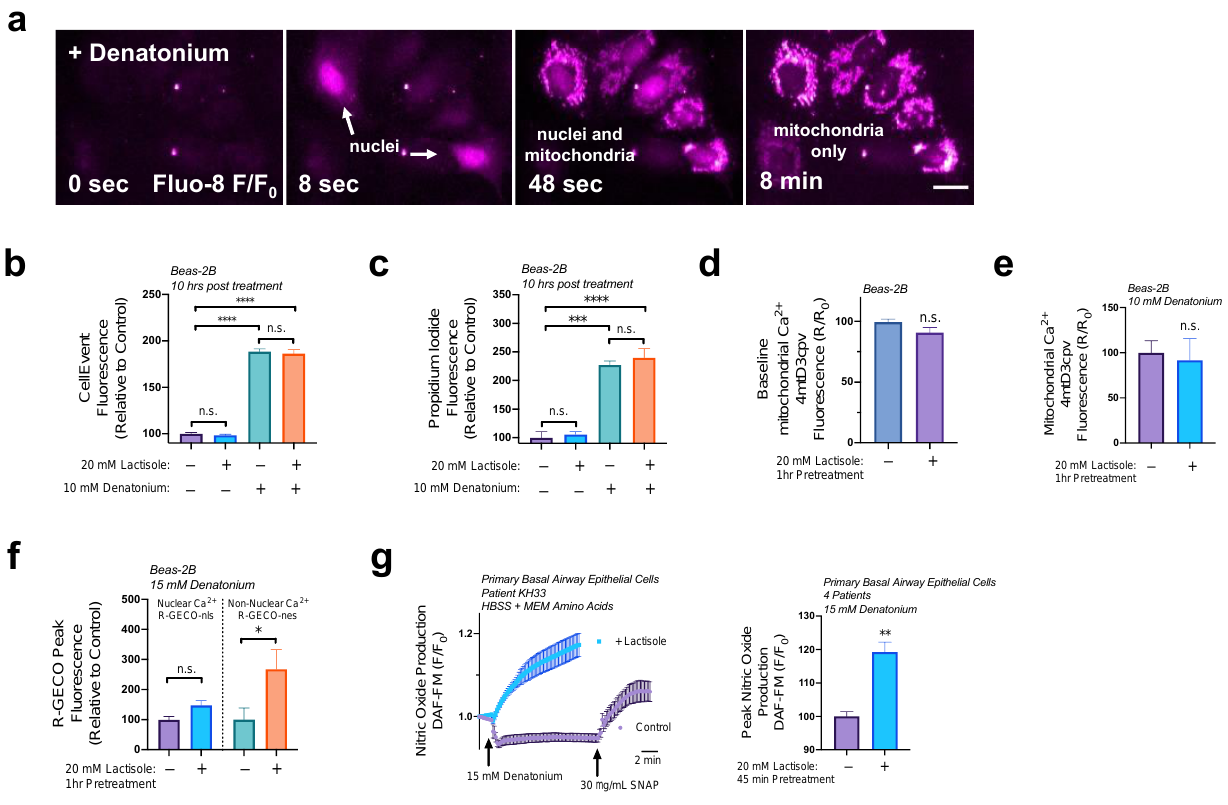
Figure 6. Lactisole increases denatonium-induced cytosolic Ca 2+ elevations and NO production. ( a ) Fluorescence images showing time course of denatonium-induced Ca 2+ elevations in starting nuclei then persisting in the mitochondria in airway epithelial cells; original image summarizing our findings from [24]. ( b ) The 20 mM lactisole pretreatment (1 h) does not alter caspase 3/7 activity initiated by denatonium signaling pathways. ( c ) The 20 mM lactisole pretreatment (1 h) does not alter cell death initiated by denatonium signaling pathways as detected by propidium iodide staining. ( d ) No changes in baseline mitochondrial Ca 2+ levels with 20 mM lactisole pretreatment (1 h) were observed in Beas-2B cells. ( e ) There were no significant changes in denatonium-induced mitochondrial Ca 2+ elevations with 20 mM lactisole pretreatment (1 h) in Beas-2B cells. ( f ) The 20 mM lactisole pretreatment (1 h) increased denatonium-induced non-nuclear Ca 2+ elevations and had no effect nuclear Ca 2+ elevations. ( g ) Primary basal airway epithelial cells in the presence of 1x MEM AA and with 20 mM lactisole pretreatment (1 h) initiate NO production in response to 15 mM denatonium. Traces are representative of ≥ 3 experiments. Bar graphs containing two comparisons were analyzed via t -test; bar graphs containing >2 comparisons were analyzed via ANOVA using Bonferroni’s post-test for multiple comparisons * p < 0.05, ** p < 0.01, *** p < 0.001 **** p < 0.0001, “n.s.” represents no